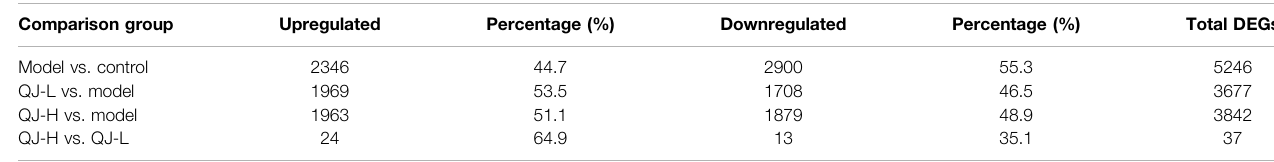
TABLE 4 | Differentially expressed genes in the different comparison